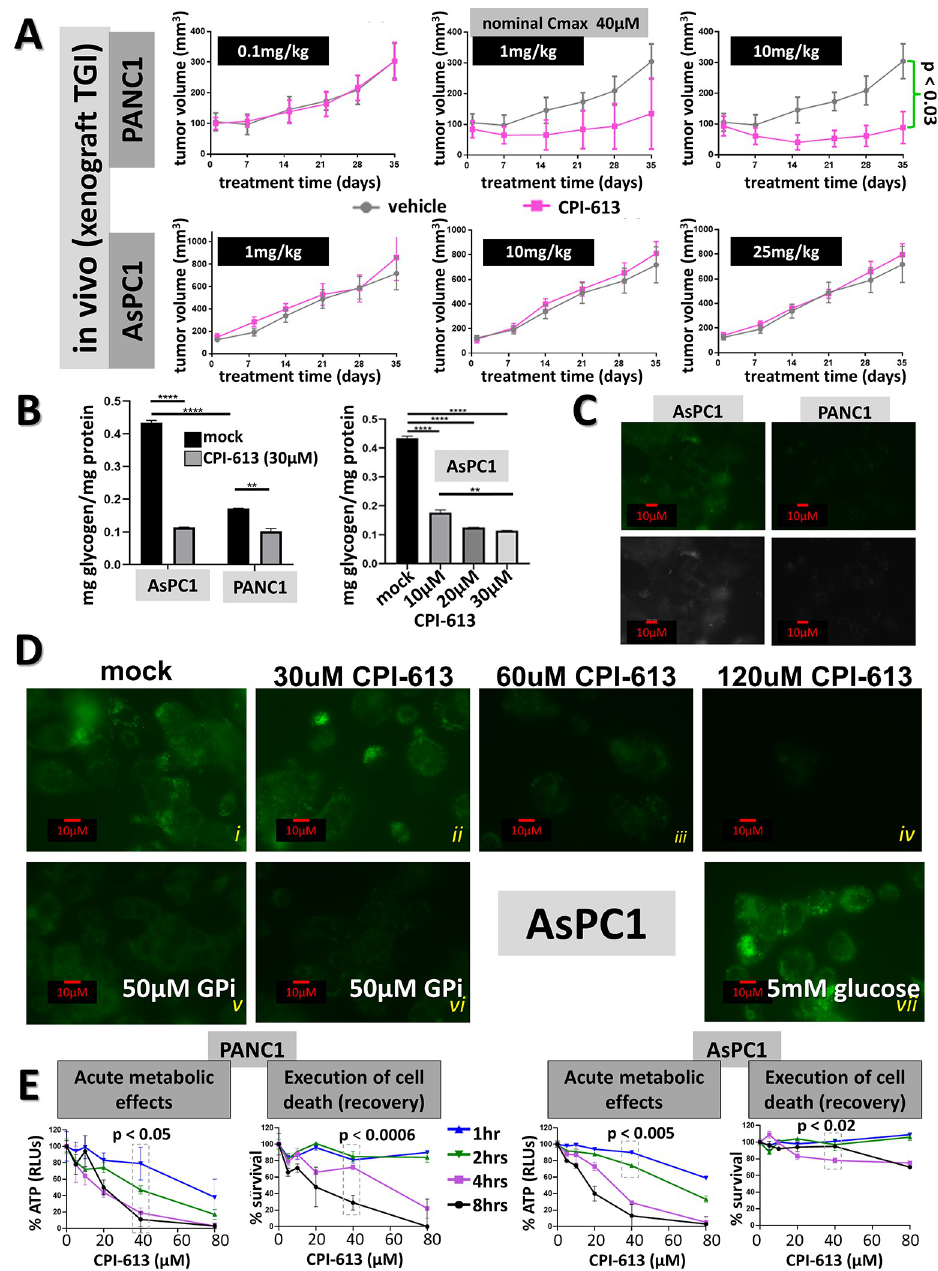
Fig 2. Endogenous nutrient stores correlate with the CPI-613 response in vitro and in vivo . A: Xenograft tumor growth inhibition (TGI) assessment of in vivo CPI-613 sensitivity of PANC1 and AsPC1 tumors . Tumors we inoculated subcutaneously on the flank and drug was administered intraperitoneally (IP) three times per week (MWF) (Materials and Methods). Nominal Cmax indicates the drug concentration that would be achieved if the entire IP dose moved immediately and exclusively into the blood. Actual Cmax experienced by tumors will generally be lower than this value. Nonetheless, this value serves as a semiquantitative assessment of the relationship between in vivo and in vitro dosing in the studies herein. All arms in this study had five animals. B: Comparison of endogenous glycogen stores and their CPI-613-induced depletion in PANC1 and AsPC1 PDAC cells . Cells were treated as indicated in CBS2 for 3hrs after standard pretreatment in CM/ns (legend to Figs 1A and S1A). �� indicates p < 0.01. ���� indicates p < 0.0001. C: Comparison of lipid store staining in PANC1 (sensitive) and AsPC1 (resistant) PDAC cell lines . Lipid fluorescence staining and microscopy using BODIPY493/503 was carried out with cells treated as the controls in panel B and as in Materials and Methods. At top is the pseudo-color green lipid staining and at bottom are the same data in monochrome. D: Response of AsPC1 lipid store staining to CPI-613 treatment . Lipid staining fluorescence microscopy